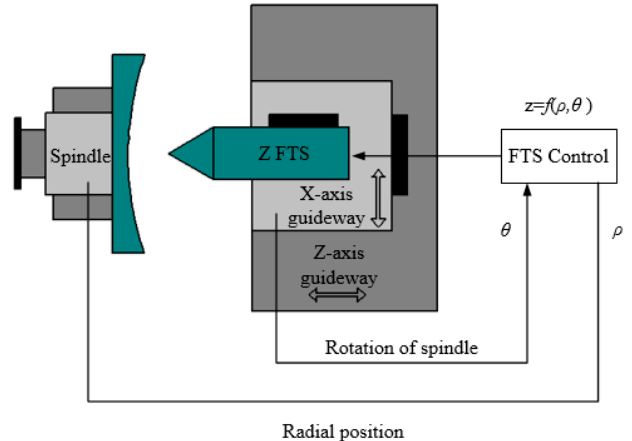
Figure 6. FTS machining